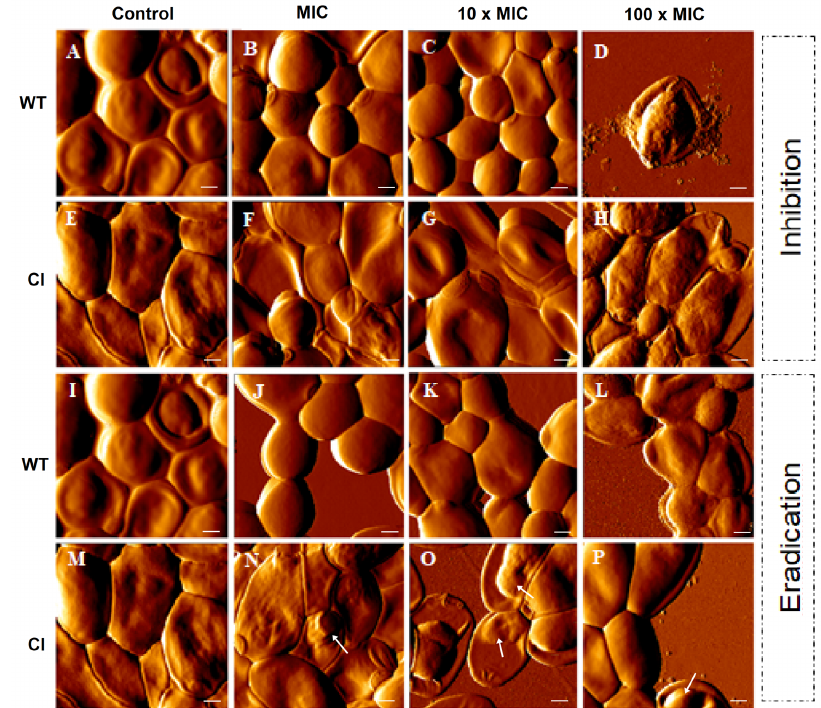
Figure 2. AFM images of C. albicans biofilms. Formation (control) ( A , E , I , M ), inhibition, and eradication assays were performed for both strains (wild-type and clinical isolate). Images show the effect on C. albicans of the antimicotic peptide at different concentrations (MIC, 10 × MIC, and 100 × MIC) ( B–D , F–H , J–L , N–P ). Images of formation of biofilm represent the control without peptide. Total scanning area for each image: 10 × 10 µ m 2 . Vesicles on the cell surface ( N – P ) were identified using white arrows. Scale bars: 1 µ